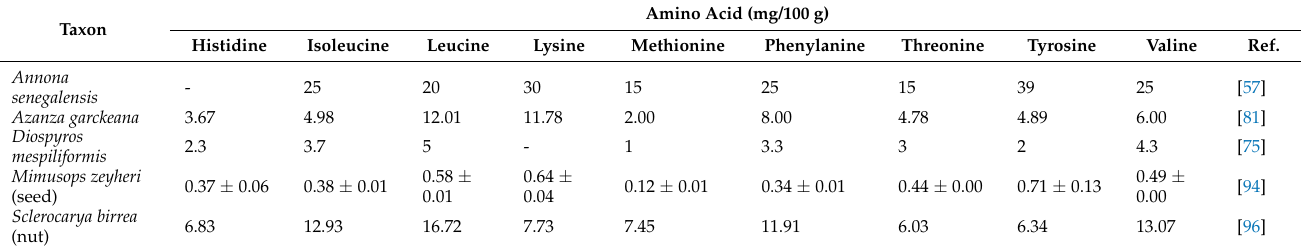
Table 2. Quantities of essential amino acids recorded in wild indigenous Southern African fruits and